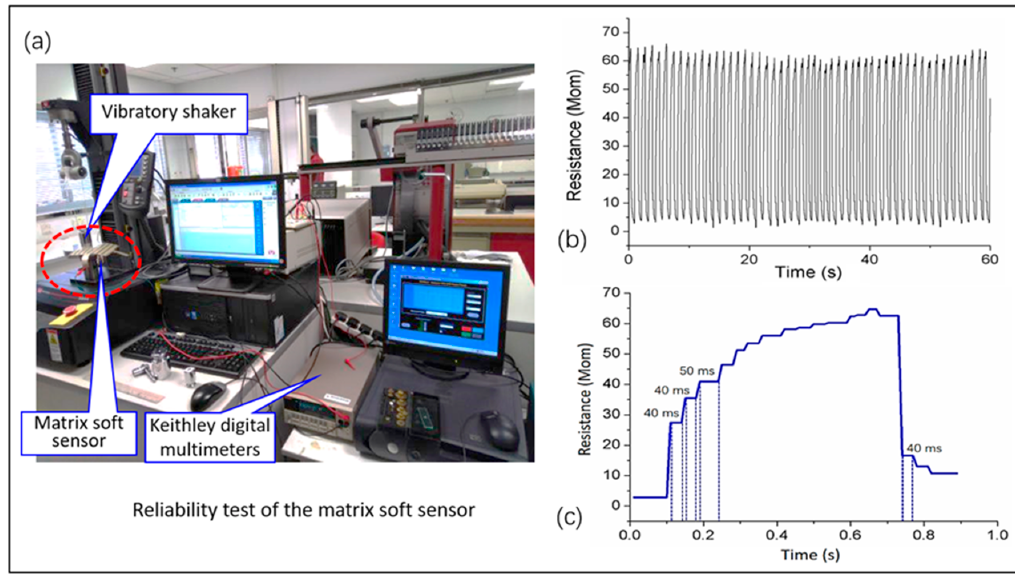
Figure 3. The response analysis of the matrix soft sensor. ( a ) A vibratory shaker and a Keithley digital multimeters system for reliability test of the matrix soft sensor; ( b ) A cyclic weight loading test; ( c ) Analysis of response time.